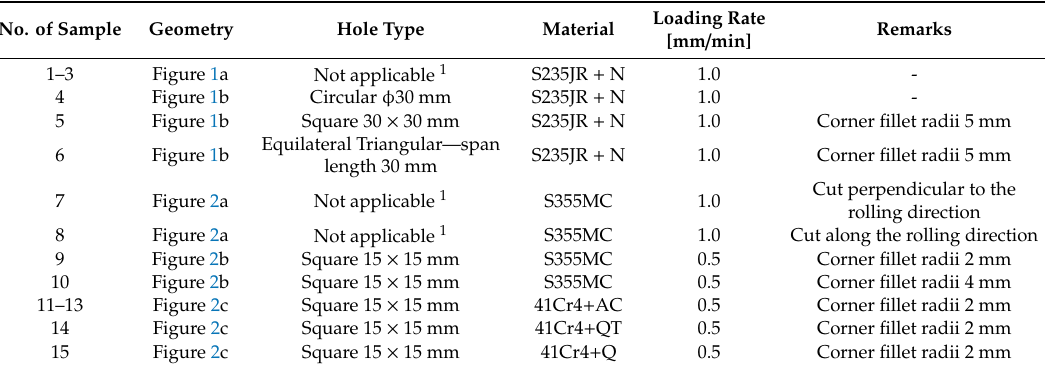
Table 3. Description of investigated